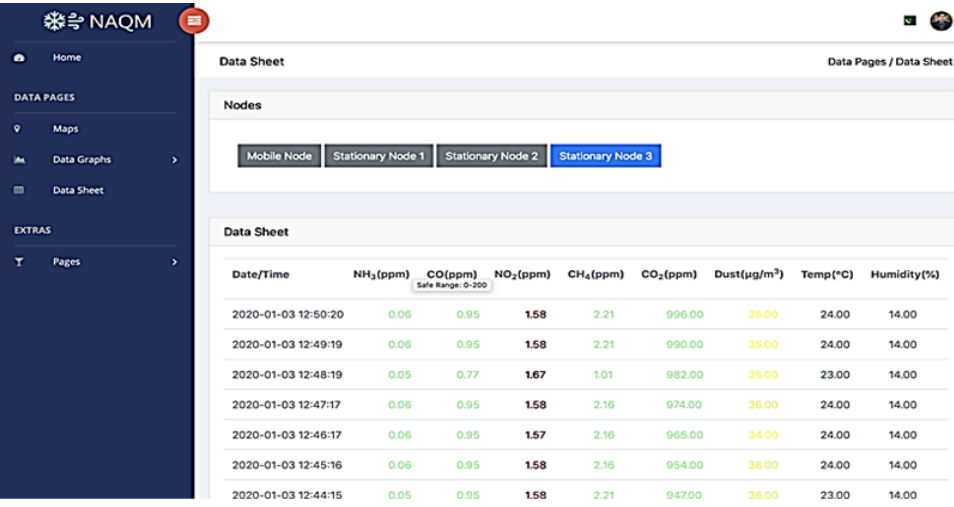
Figure 5. Web portal showing the data collected from indoor air quality IoT node.